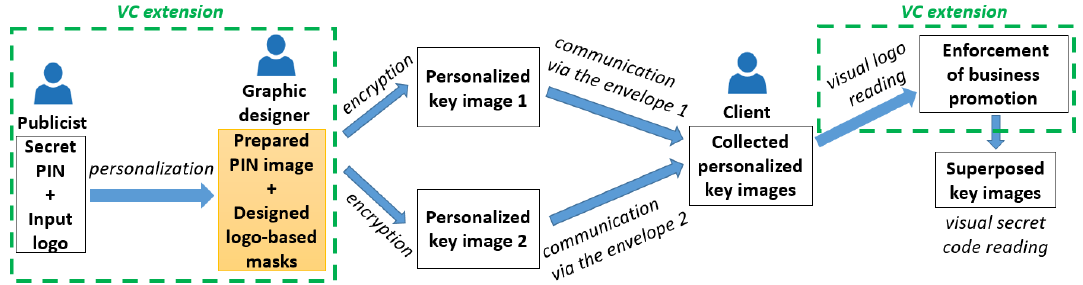
Figure 5. Proposed pictogram-based visual cryptography scheme with personalization of key images for both business promotion (e.g., via the logo of a bank service) and sharing of a secret